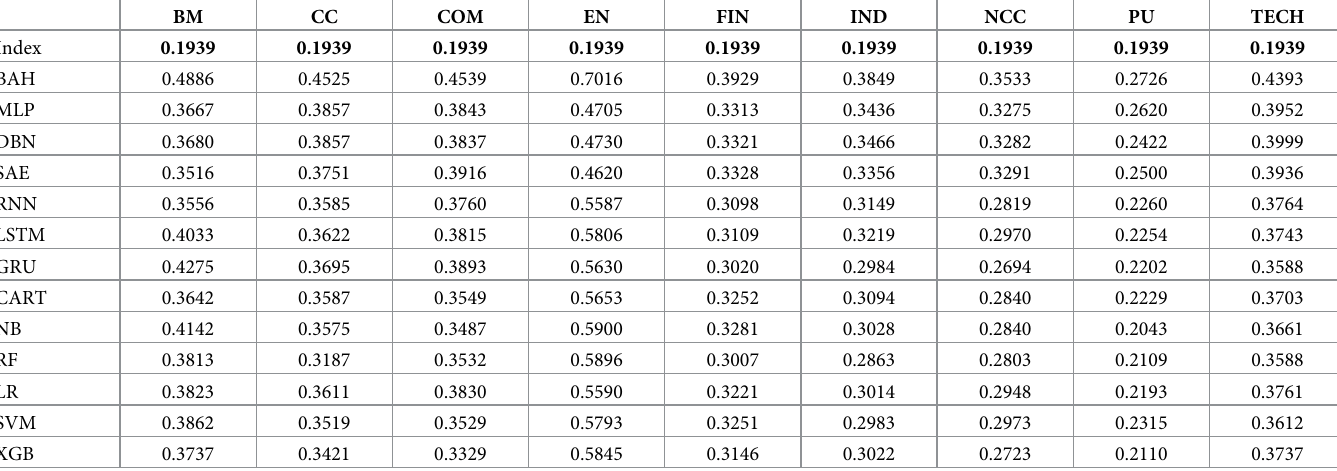
Table 7. Comparison of MDD of various trading strategies in the different industries of SPICS. Best performance is in boldface. BM CC COM EN